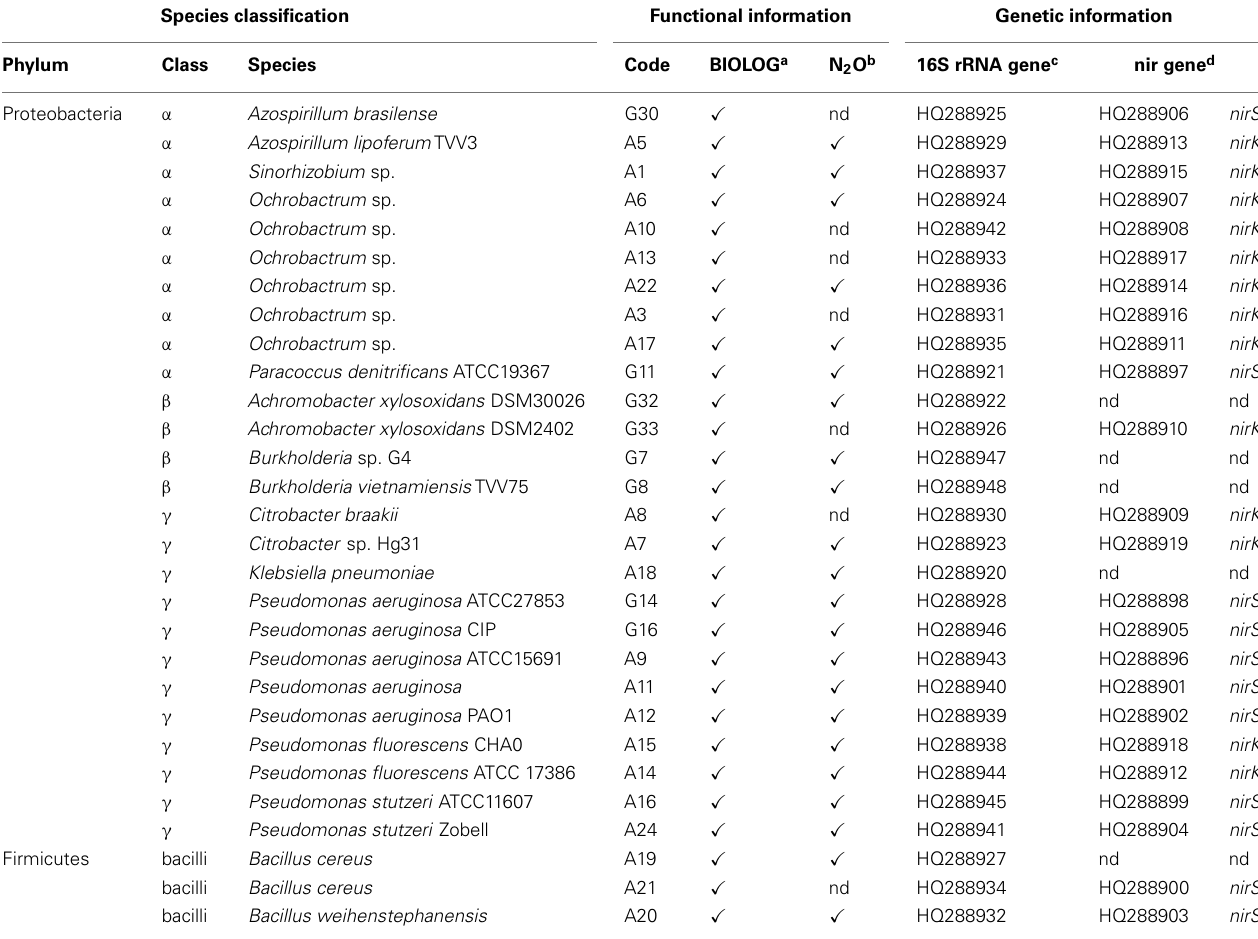
Table 1 | List of the denitrifying strains used in this work, indicating which functional and genetic aspects were investigated for each one. Species